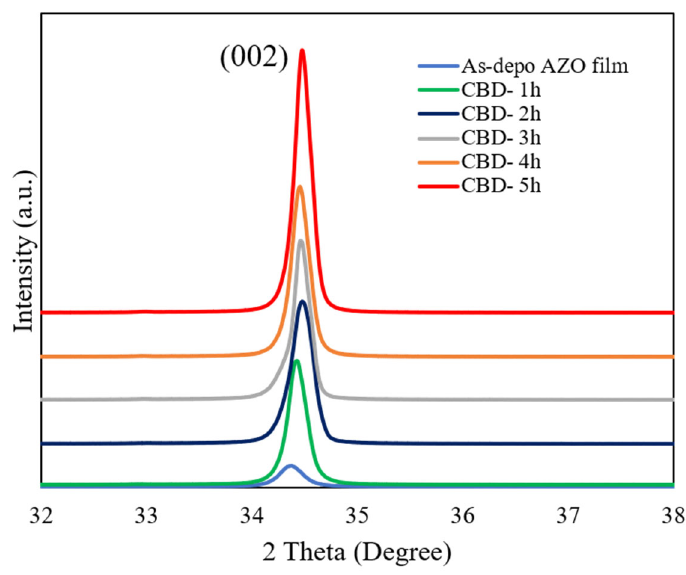
Figure 1. GIXRD patterns of ZnO nanorods with different reaction times by CBD method. Table 2. XRD analysis date of as-deposited AZO film and ZnO nanorods.